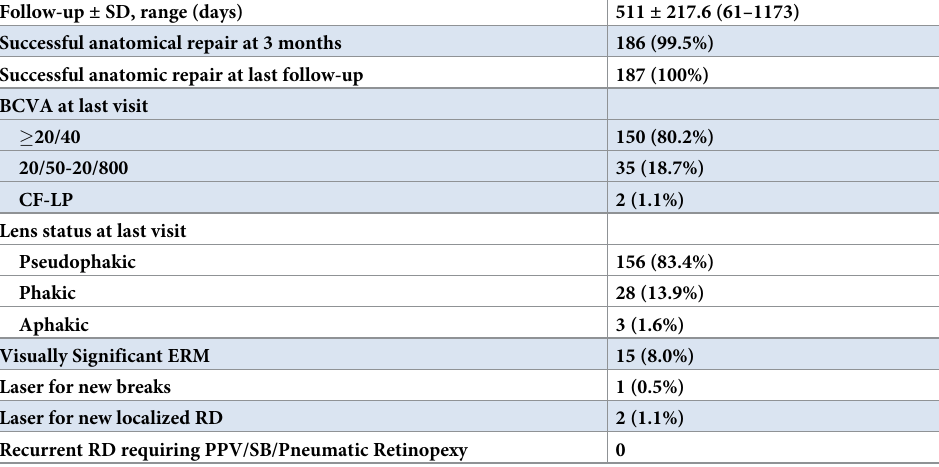
This study’s main outcome measures centered on single surgery anatomic success rate as well as final reattachment rate at last follow up. At 3 months, 186 out of 187 (99.5%) of eyes were attached following a single surgical procedure (Table 4). At last follow up, all eyes (100%) were attached. The mean follow up period was 511 days ± 217.6 days. One hundred fifty-one eyes (80.7%) had at least 1 year of follow up; in the remaining eyes, 20 (10.7%) had at least 6 months of follow up and only 16 (8.6%) had less than 6 months. There were 3 procedural inter- ventions in 3 different patients: case 1 at 1.5 month follow up was noted to have a new Table 4. Anatomic and functional